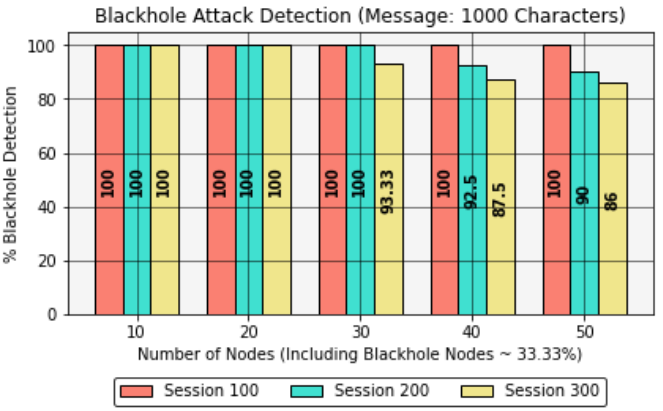
Figure 13. Blackhole node detection vs. number of